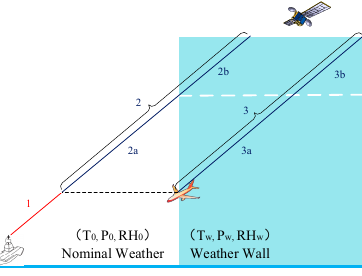
Figure 3. Weather Wall model to the right of the ship.